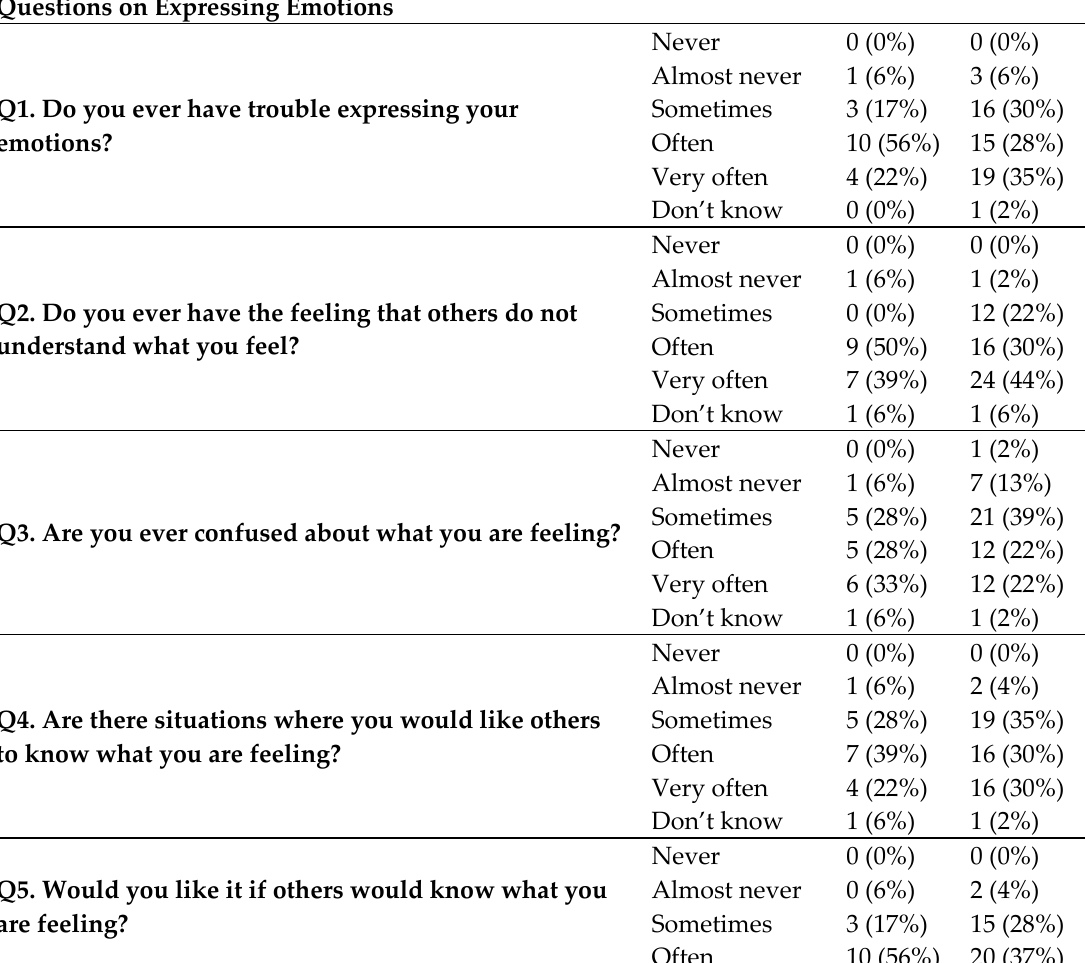
Table 2. Overview of the responses to the online